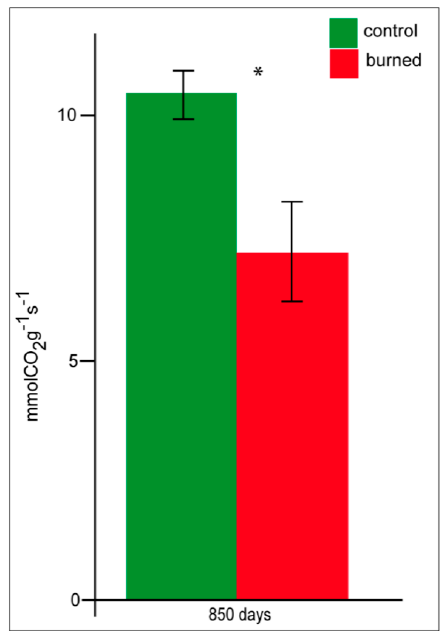
Figure 7. Respiration of litter on the 850th day of the decomposition experiment. The asterisk indicates a significant difference according Tukey’s HSD test following ANOVA ( p ≤ 0.05). Error bars represent ±SE ( n = 6).